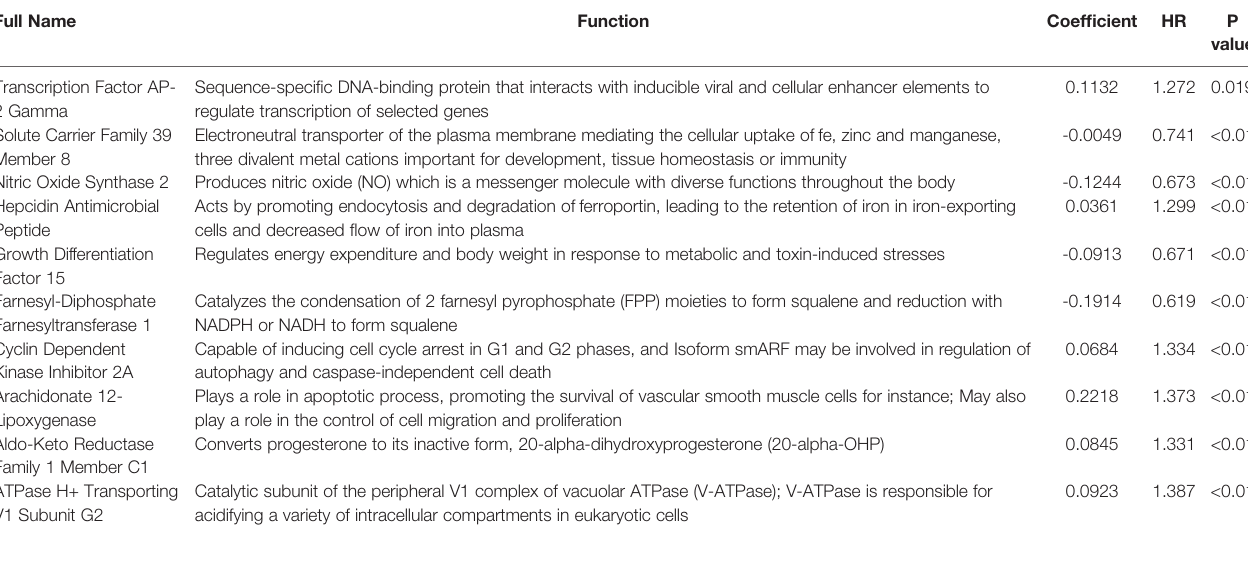
TABLE 2 | The information of the 10 genes in the multivariate Cox regression analysis.